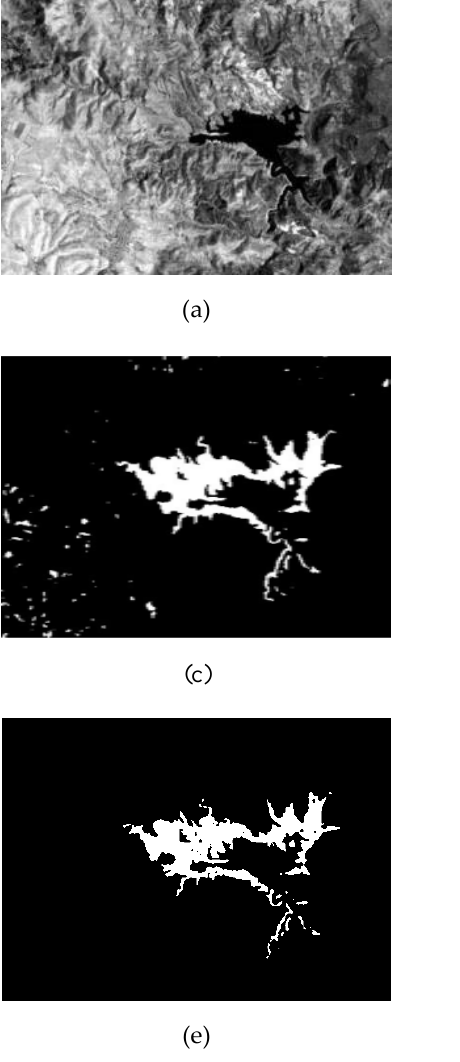
Figure 2. Detection results in Sardinia area. ( a ) the image of the Sardinia region in April 1999, ( b ) the image of the Sardinia region in May 1999, ( c ) the result of the NSCTKFCM method, ( d ) the result of the NSCTFCM method, ( e ) the result of L-V-NSCT, and ( f ) the reference image of the